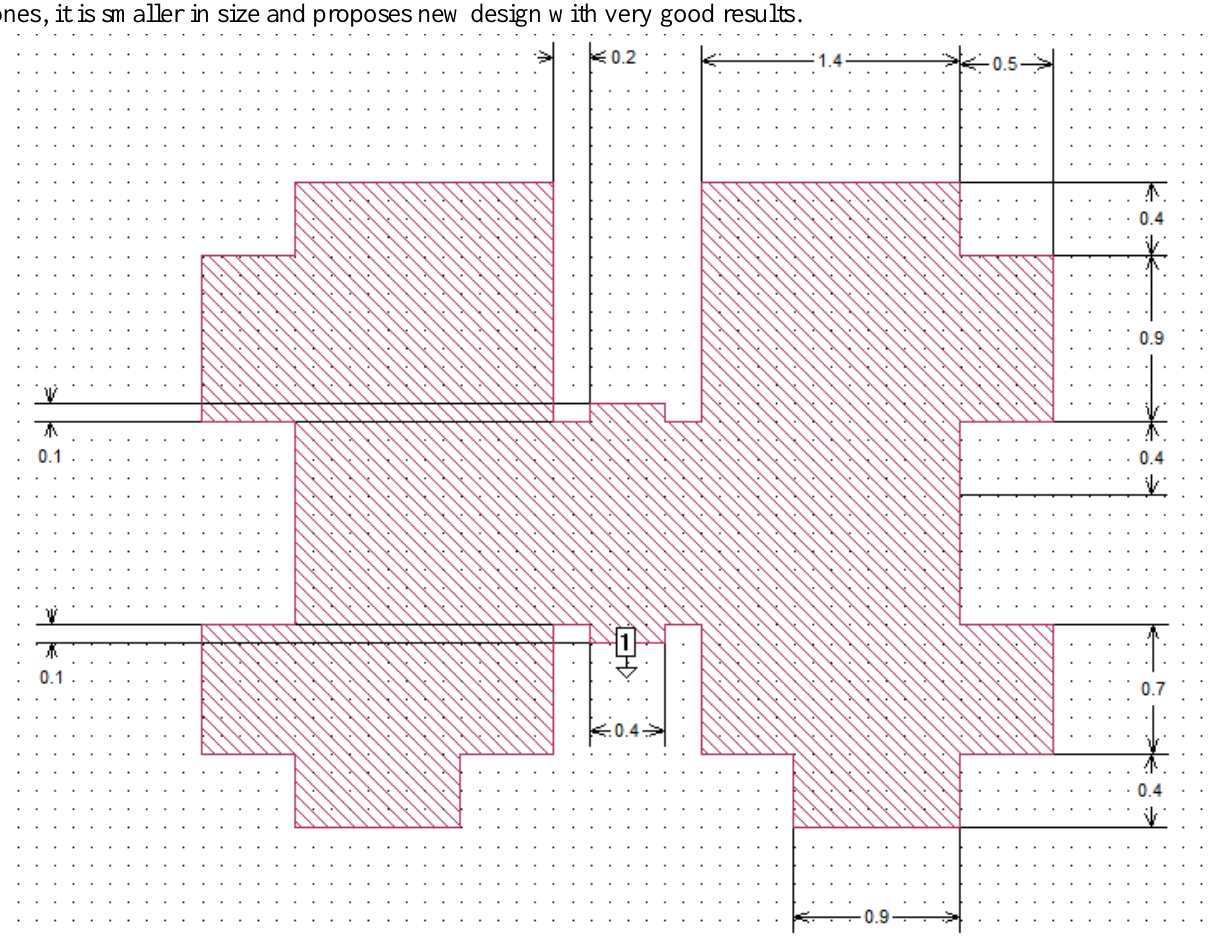
Figure 1. Design of the slitted inset fed butterfly-shaped microstrip patch